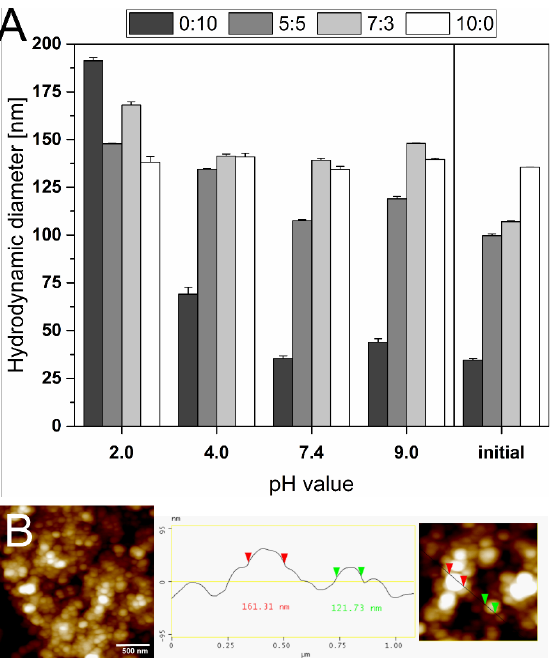
Figure 4. ( A ) The hydrodynamic diameter of liposomes composed of tetraether lipids (TEL) and Phospholipon 100H (Ph) in different molar ratios (0:10, 5:5, 7:3, 10:0; TEL:Ph) incubated for 4 d at pH 2.0, 4.0, 7.4, and 9.0, respectively, compared to initial values. AFM images in height or phase mode of ( B ) 7:3 TEL:Ph liposomes incubated for 4 d at pH 2.0. The scale bar in B represents 500 nm. Table 3. The polydispersity index (PDI) of liposomes composed of tetraether lipids (TEL) and Phos- pholipon 100H (Ph) in different molar ratios (0:10, 5:5, 7:3, 10:0; TEL:Ph) incubated for 4 d at pH 2.0, 4.0, 7.4, and 9.0, respectively.